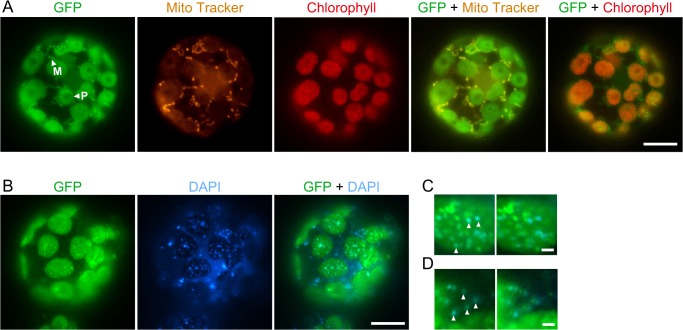
Subcellular localization of the RECG-GFP protein in P. patens protoplast cells.
A. Subcellular localization of GFP fused to RECG N-terminal region. The fluorescence of GFP was merged with Mito Tracker or chlorophyll autofluorescence. Plastids were distinguished by the distribution of their chlorophyll autofluorescence, while mitochondria were detected by staining with Mito Tracker Orange. The arrowheads with P and M denote examples of RECG-GFP localized to plastid and mitochondrion, respectively. B. Subcellular localization of GFP fused to full-length RECG. The fluorescence of GFP was merged with DAPI fluorescence. C and D. Localization of full-length RECG-GFP to plastid (C) and mitochondrial (D) nucleoids. GFP fluorescence was merged with DAPI fluorescence (left panels) and then GFP fluorescence was shifted to left (right panels). The arrowheads denote examples of correspondence between GFP and DAPI signals. Bars = 10 μm in A and B, and 1 μm in C and D.